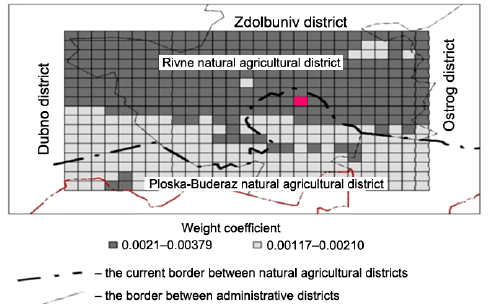
Fig. 2. Maps of natural agricultural zoning of Zdolbuniv district of Rivne